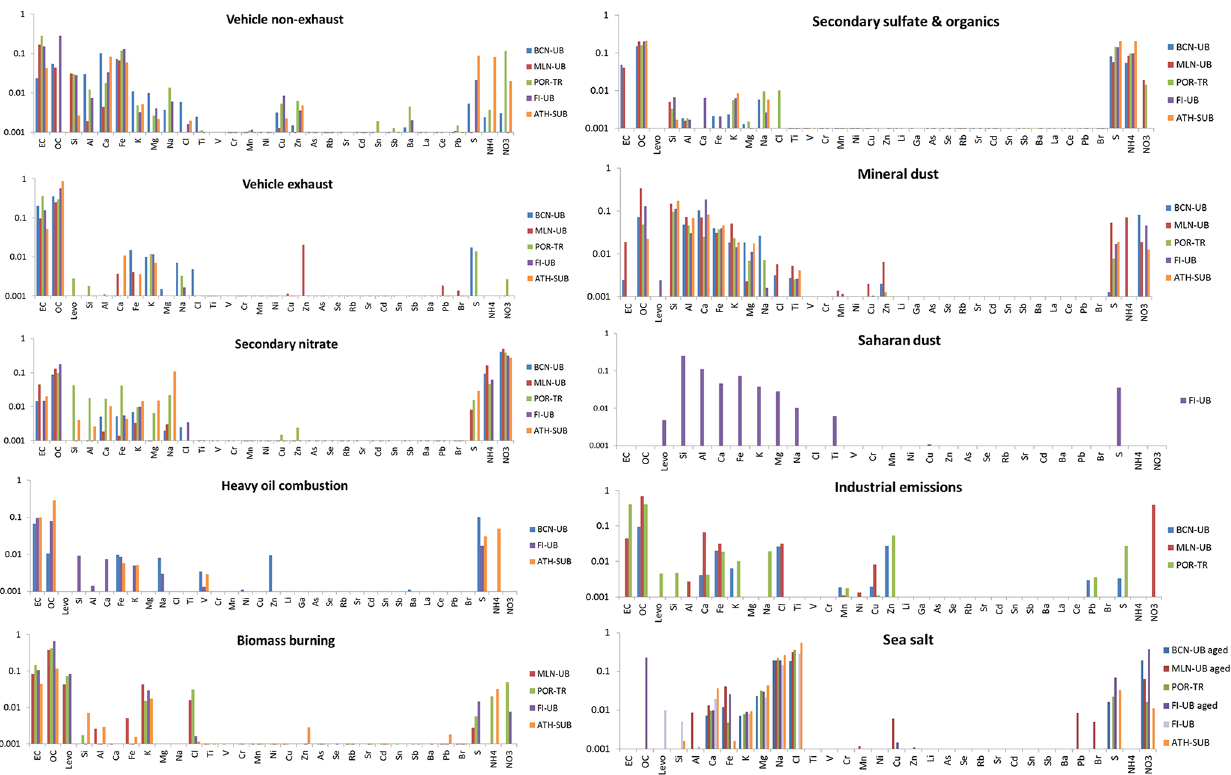
Figure 3. PMF factor profiles (µgµg − 1 ) for each monitoring site. At MLN-UB and POR-TR, the SSO factor includes heavy oil combustion.